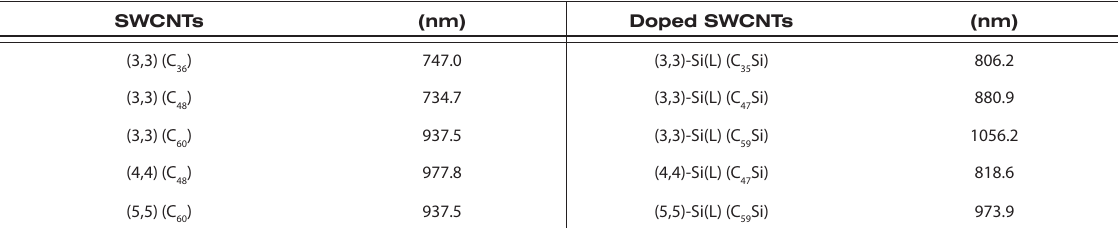
Table 2. The first absorption peaks in the UV Spectra of the SWCNTs calculated using INDO/CIS method SWCNTs